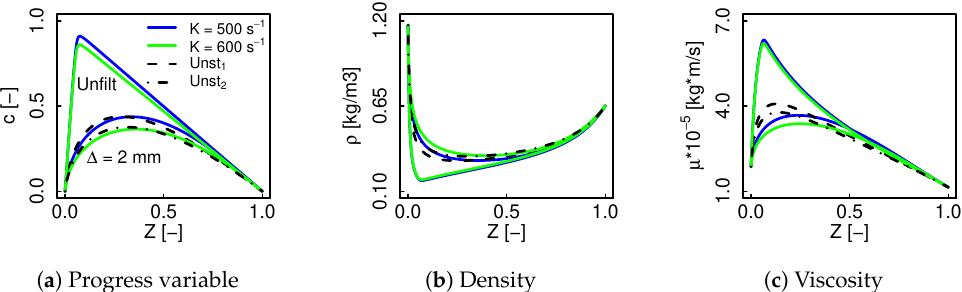
Figure 12. Variable transformation due to filtering for two steady state flamelets and their similitude with unfiltered unsteady flamelets when plotted in Z space. Solid lines steady profiles, dashed lines unsteady profiles.